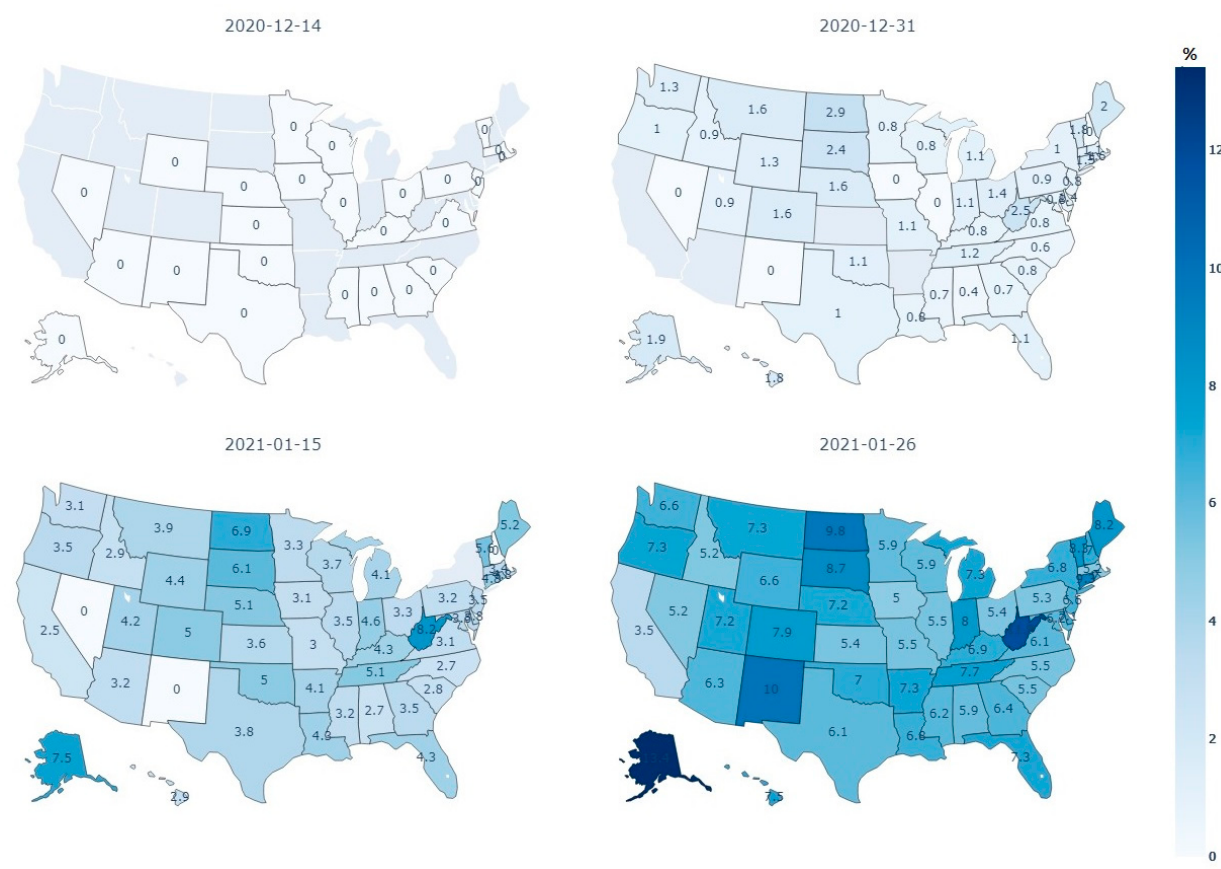
Figure 2. Percentage of the population in each state who received at least 1 dose in the study period (Source: authors’ calculation based on the data retrieved from the Johns Hopkins University Centers for Civic Impact COVID-19 data analysis and visualizations repository).